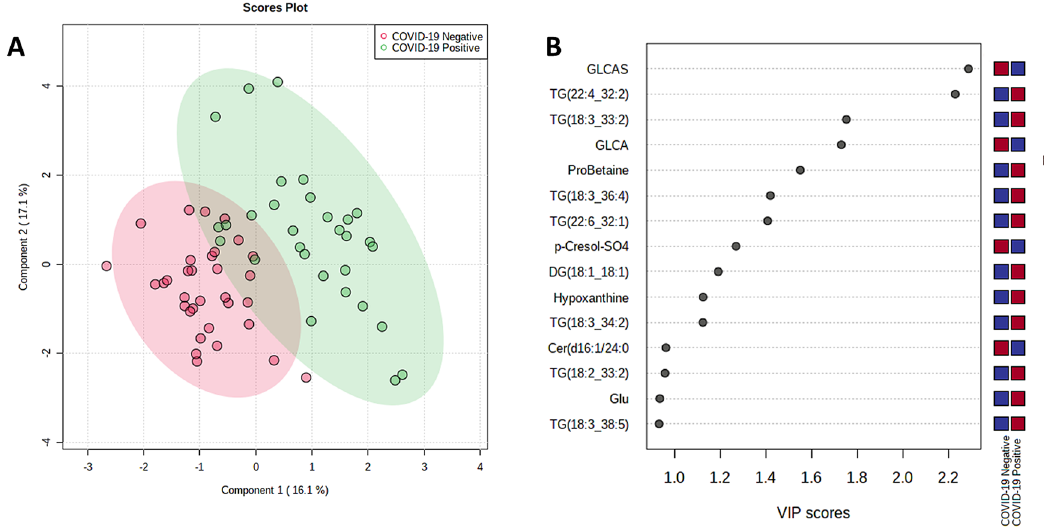
Figure 5. ( A ) PLS-DA plot and ( B ) high VIP score metabolites for serum, COVID-19 positive versus COVID- 19 negative.